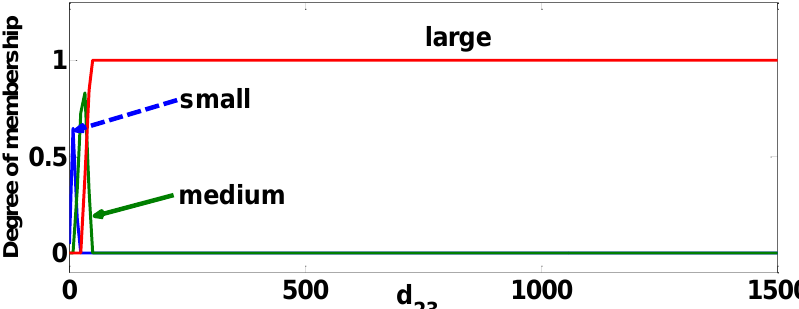
Figure 14. Membership functions for the distance 𝑑 13 .